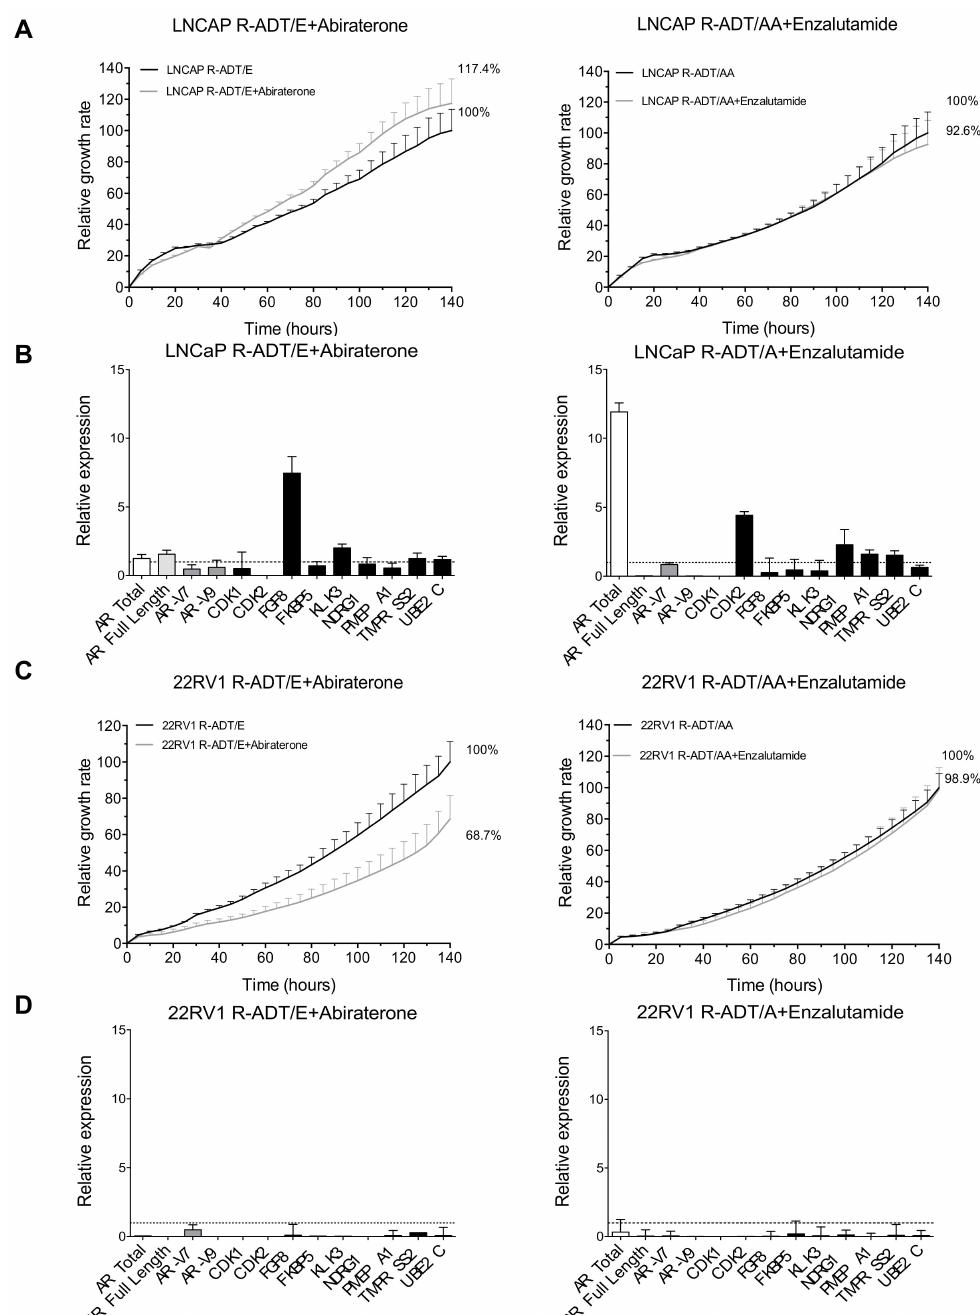
Figure 7. Analysis of cross-resistance between Abiraterone and Enzalutamide from the concomitant cellular models (R- ADT/NHAs + Abiraterone or Enzalutamide). In order to study the cross-resistance to the complementary antiandrogen, R-ADT/E cells were treated with AA (20 µ M) (R-ADT/E + Abiraterone), the R-ADT/A cell line was exposed to Enz (40 µ M) for 5 days (R-ADT/AA + Enzalutamide), and cell growth was evaluated by xCELLigence. ( A ) Cell proliferation analysis results for LNCaP cell lines using xCELLigence. Results have been standardized considering the final value after 5 days R-ADT/NHAs cell lines to 100%. LNCaP R-ADT/E + Abiraterone (left panel) and LNCaP R-ADT/A + Enzalutamide (right panel). Data shown correspond to the mean ± SD calculated from the quadruplicates made for each condition. ( B ) qPCR analysis for AR isoforms and AR target genes. The results are shown normalized with respect to endogenous control (GADPH). The error bars shown correspond to the SD calculated from triplicates. ( C ) Cell proliferation assays and ( D ) qPCR analysis for 22RV1 R-ADT/E + Abiraterone (left panels) and 22RV1 R-ADT/A + Enzalutamide (right